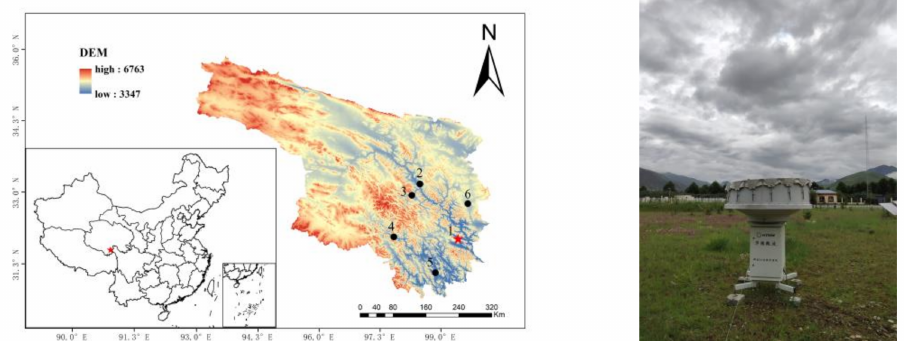
Figure 1. Site geographic distribution information (the red five-pointed star represents Yushu, and the black origin represents Qumalai, Zhiduo, Zaduo, Nangqian, Qingshuihe, respectively) ( left ) and Ka-band millimeter-wave cloud radar system (photo from Yushu meteorological station) ( right